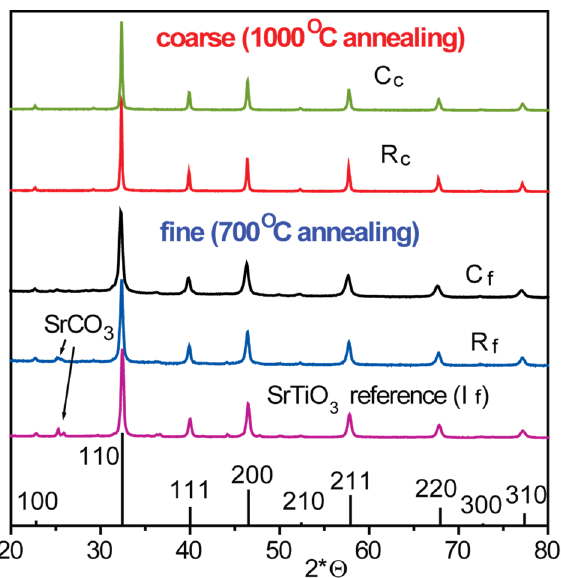
Figure 2. XRD spectra of the fine and coarse nanopowders with ( C f , C c ) and without carbon doping ( R f , R c ). Reference ( I f ) STO powder curve and standard peaks of STO (black bars) are given for com- parison.